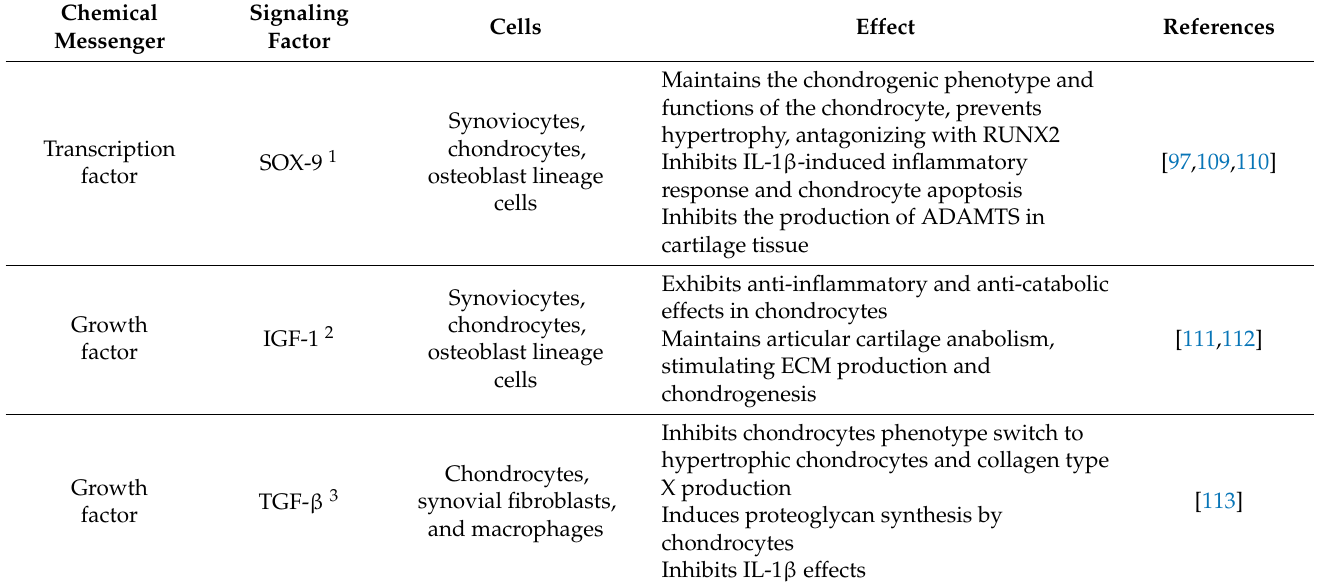
Table 1. The overview of signaling molecules produced by cells in the context of compartments in the healthy